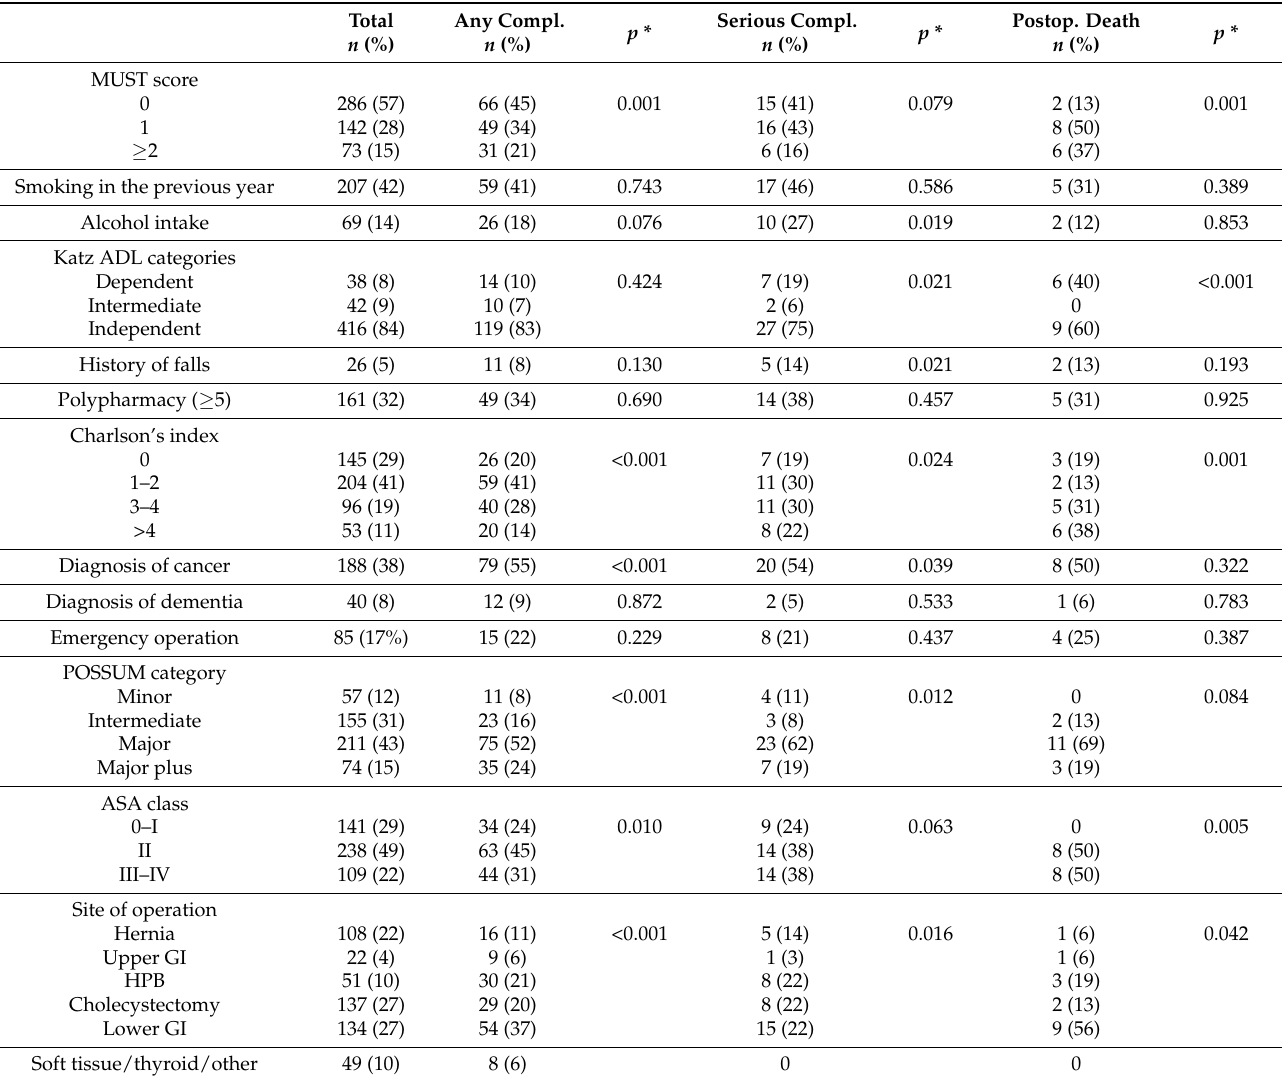
Table 3. Preoperative factors associated with postoperative complications in 501 older patients undergoing general surgery. Any Compl. n